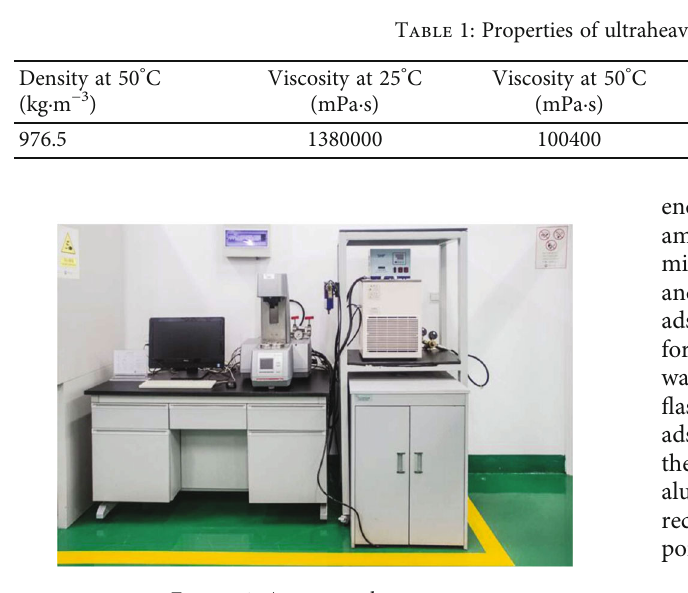
Figure 1: Antongpa rheometer.